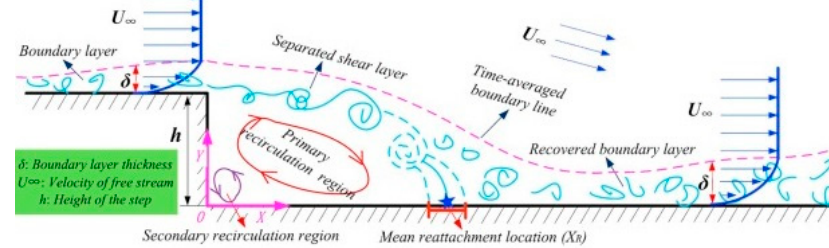
Figure 1. Sudden Expansion Phenomenon [2].